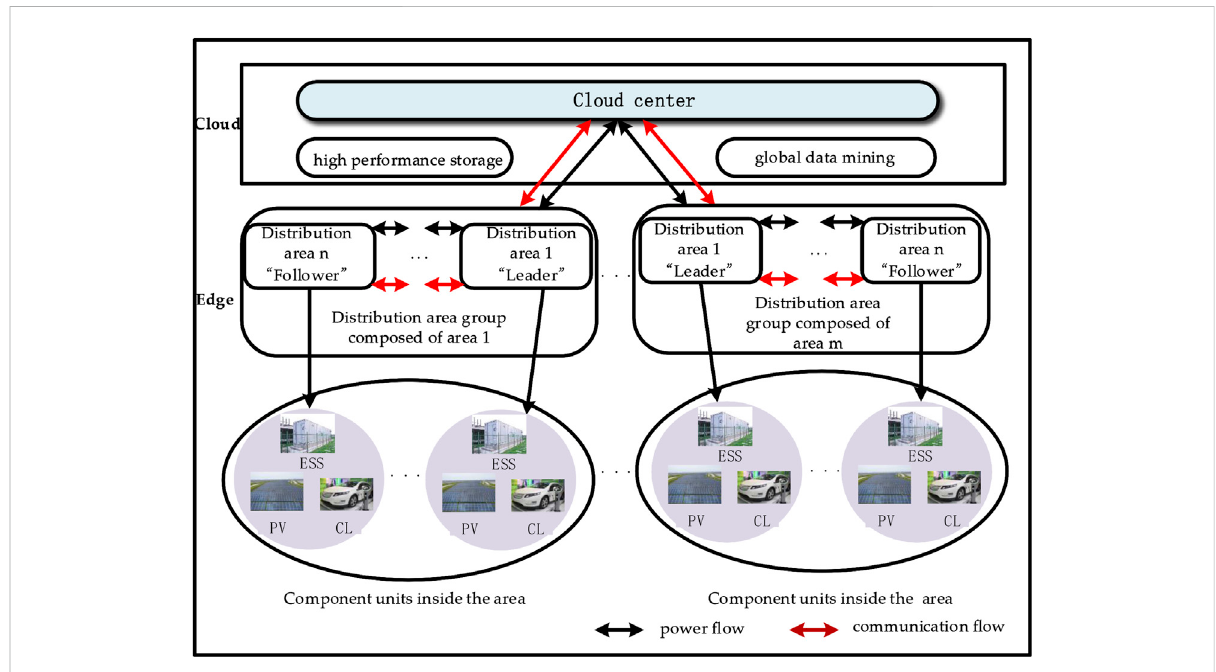
FIGURE 1 Real-time dispatch framework for distribution transformer supply zone cluster based on cloud-edge collaboration